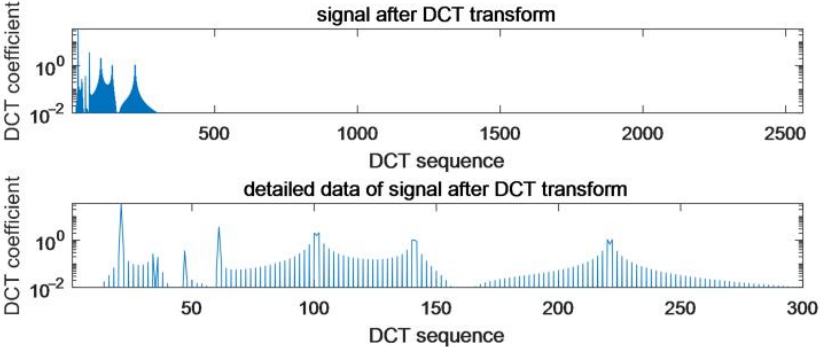
Energies 2022 , 15 , x FOR PEER REVIEW 11 of 18